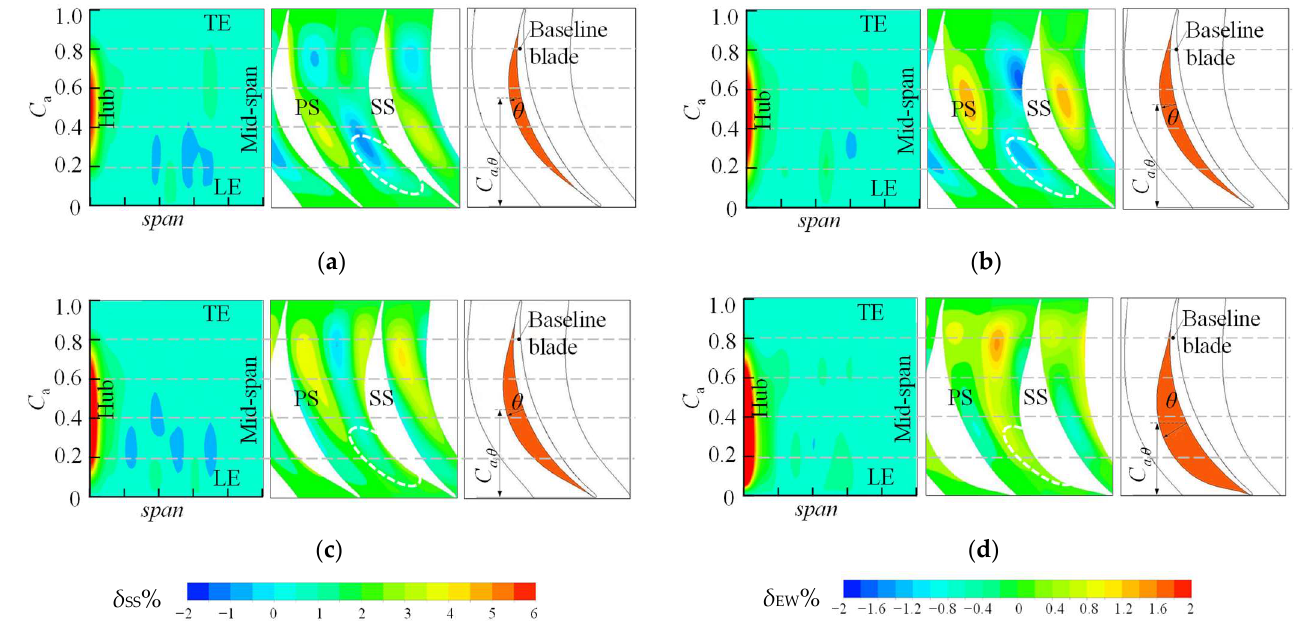
Figure 9. Profiling results on the end wall, SS, and SS corner. ( a ) Case A; ( b ) Case B; ( c ) Case C; ( d ) Case D.